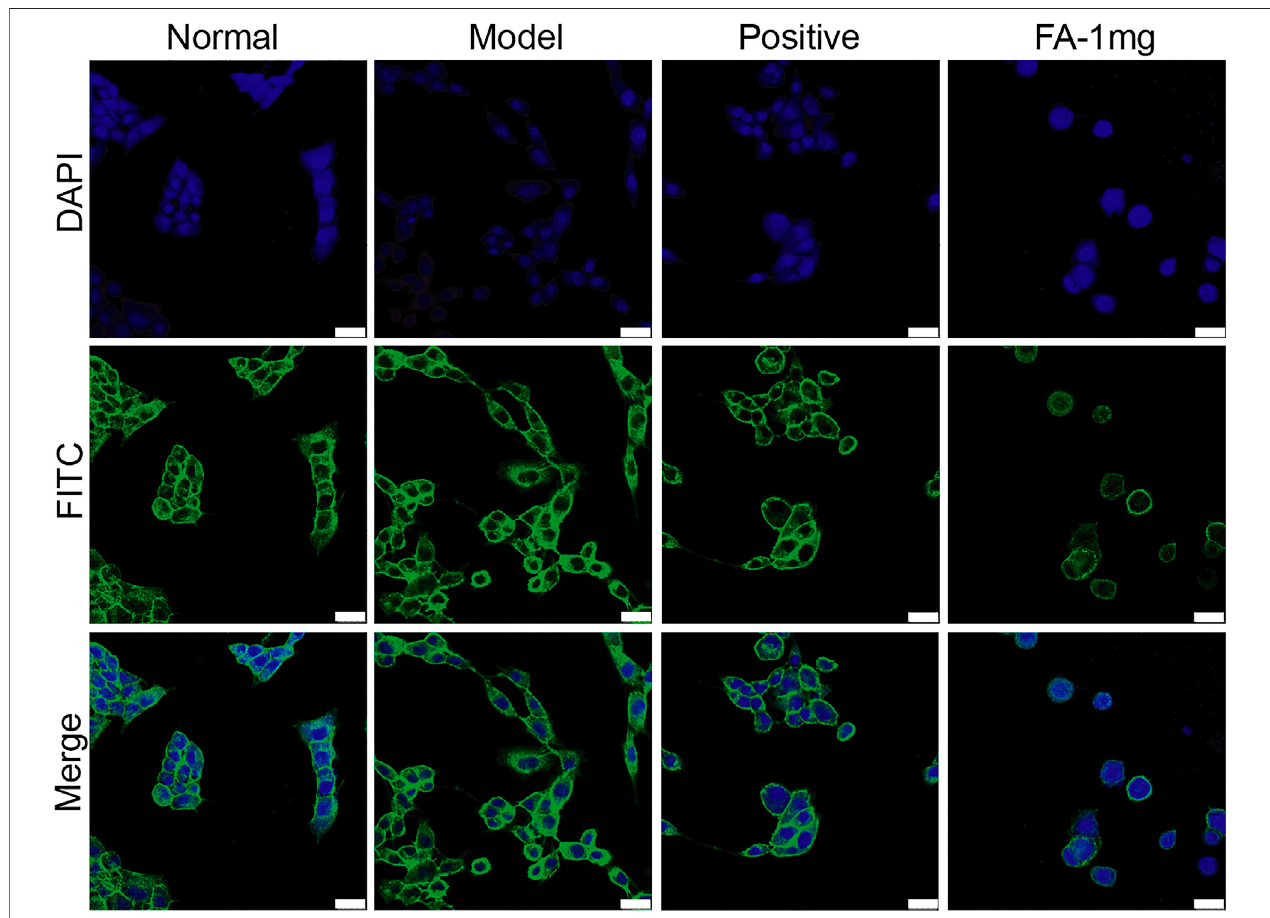
FIGURE3| Representativeimagesofthecytoskeleton(green)intheHSCstreatedwithBMSCsorBMSC&FA(1 mg/ml).DAPIwasusedtostaincellnuclei(original magni fi cation, ×40; scale bars: 25 μ m).